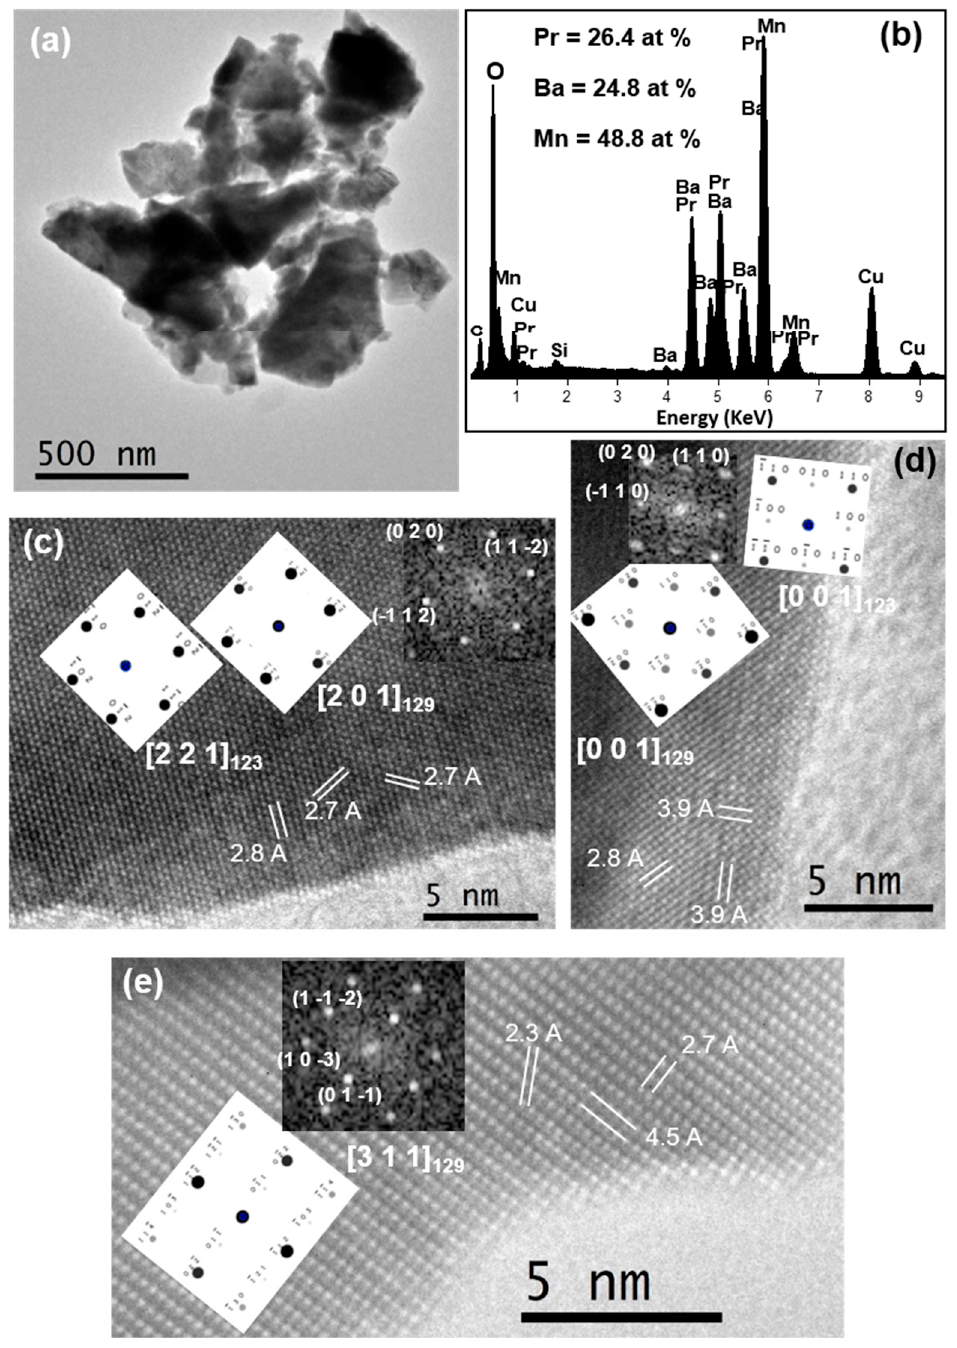
Figure 8. Microcharacterization of PBMO-m + 1150 °C/Ar sample: ( a ) TEM image; ( b ) representative EDX spectrum and the average atomic percentage of the sample; ( c – e ) HRTEM micrographs and the corresponding fast Fourier transform (FFT) and simulated ED patterns (insets).